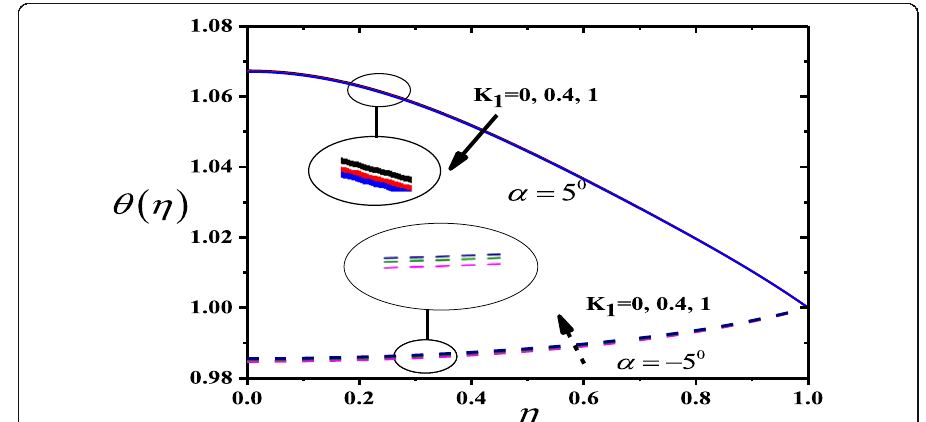
Fig. 9 Temperature vs. K 1 in shrinking divergent and stretching convergent